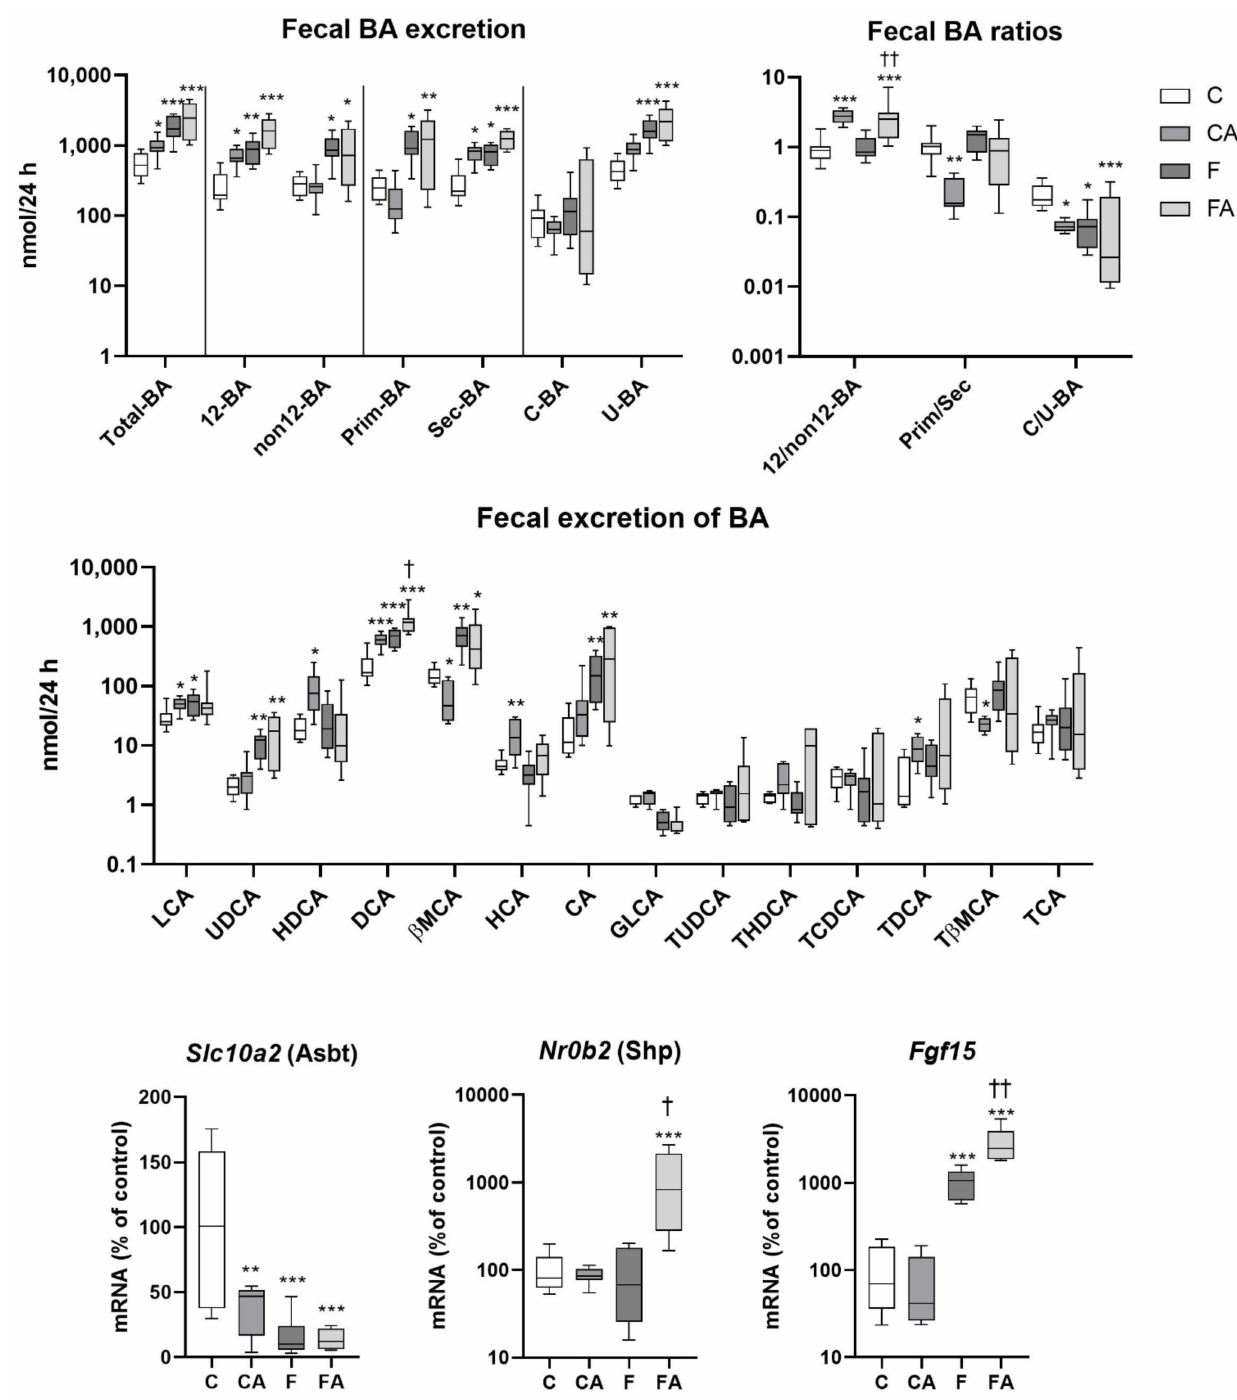
Figure 6. F diet consumption and atorvastatin treatment modulated the fecal excretion of BA. NASH was induced in mice by 24 weeks of F diet consumption, with atorvastatin (A) administered orally (20 mg/kg/day) over the last three weeks. Corresponding control groups received a chow (C) diet. BA were analyzed in the feces collected within 24 h. The mRNA expression levels of essential BA transporters and regulators were analyzed in ilea. Data are presented as median values, with boxes and whiskers representing the interquartile range and fifth to 95th percentiles, respectively. * p < 0.01, ** p < 0.01, and *** p < 0.001 atorvastatin and/or F-diet vs. vehicle-administered chow diet–treated mice; † p < 0.05 and †† p < 0.01 atorvastatin-treated vs. vehicle-treated NASH mice. BA are presented as follows: 12 α -hydroxylated (12 BA), non12 α -hydroxylated (non12 BA), primary (Prim-BA), secondary (Sec-BA), conjugated (C-BA), unconjugated